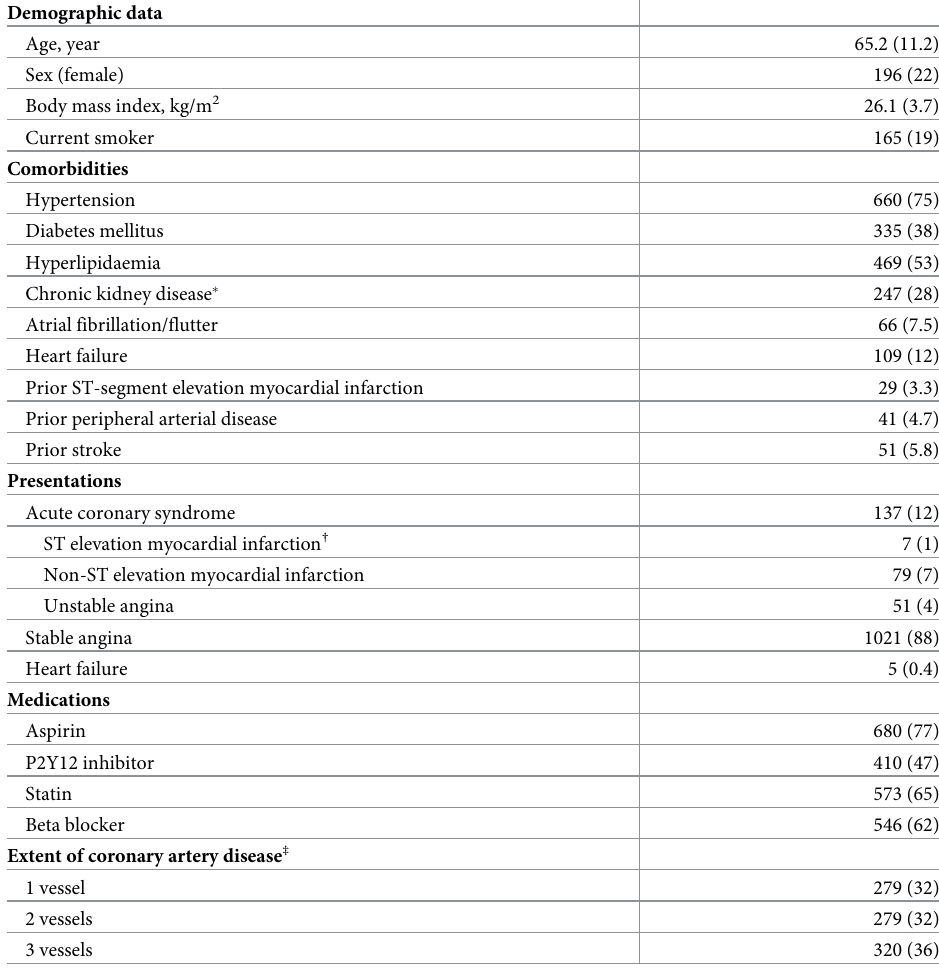
Table 1. Characteristic of the